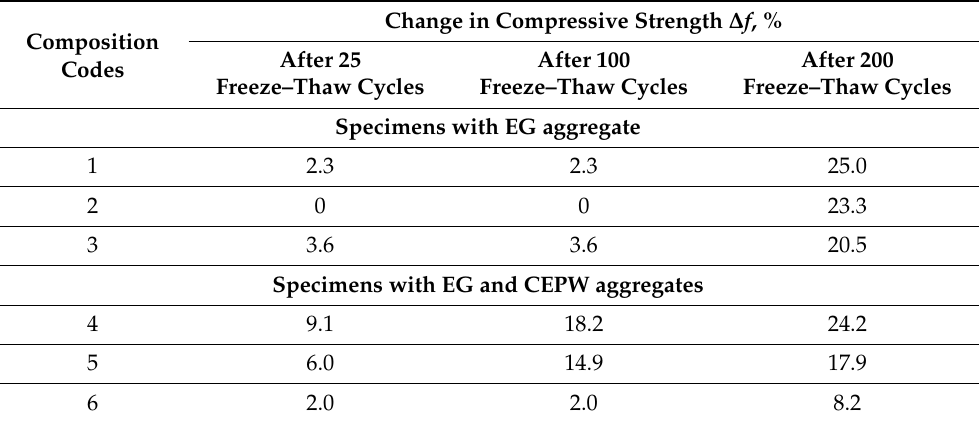
Table 8 . Changes in compressive strength after 25, 100, and 200 freeze–thaw cycles. Composition